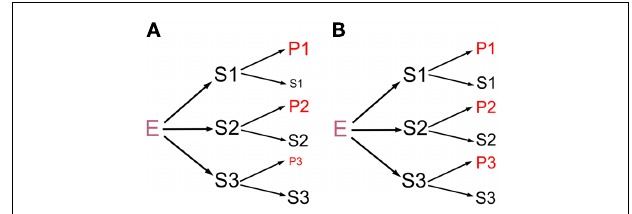
FIGURE 1 | Schematics of how an E interacts with {S}, represented by S1, S2, and S3. The interactions yield the respective products P1, P2, and P3, with the remaining S1, S2, and S3.The letter size symbolizes the abundance of S and P, with the starting S1–S3 being equal for simplicity. (A) E discriminates amongst S to yield different amounts of P1, P2, and P3, as the central hypothesis predicts. (B) E interacts with S1–S3 identically, a commonly assumed situation. Because S and P likely have different activities in vivo , (A) and (B) will lead to different functional outcomes